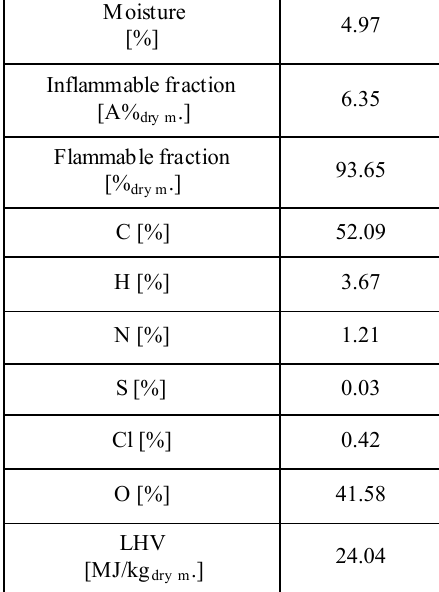
Fig. 1 . Experimental setup . 1-reaction chamber, 2-fuel feeder, 3- air blower and regulation system, 4-grate, 5-syngas outlet, 6- syngas pipeline (syngas sampling point), 7-monitoring of flows and temperatures, 8-biomass fuel, 9-thermal insulation, 10- temperature sensors, 11-air flow measurement m 3